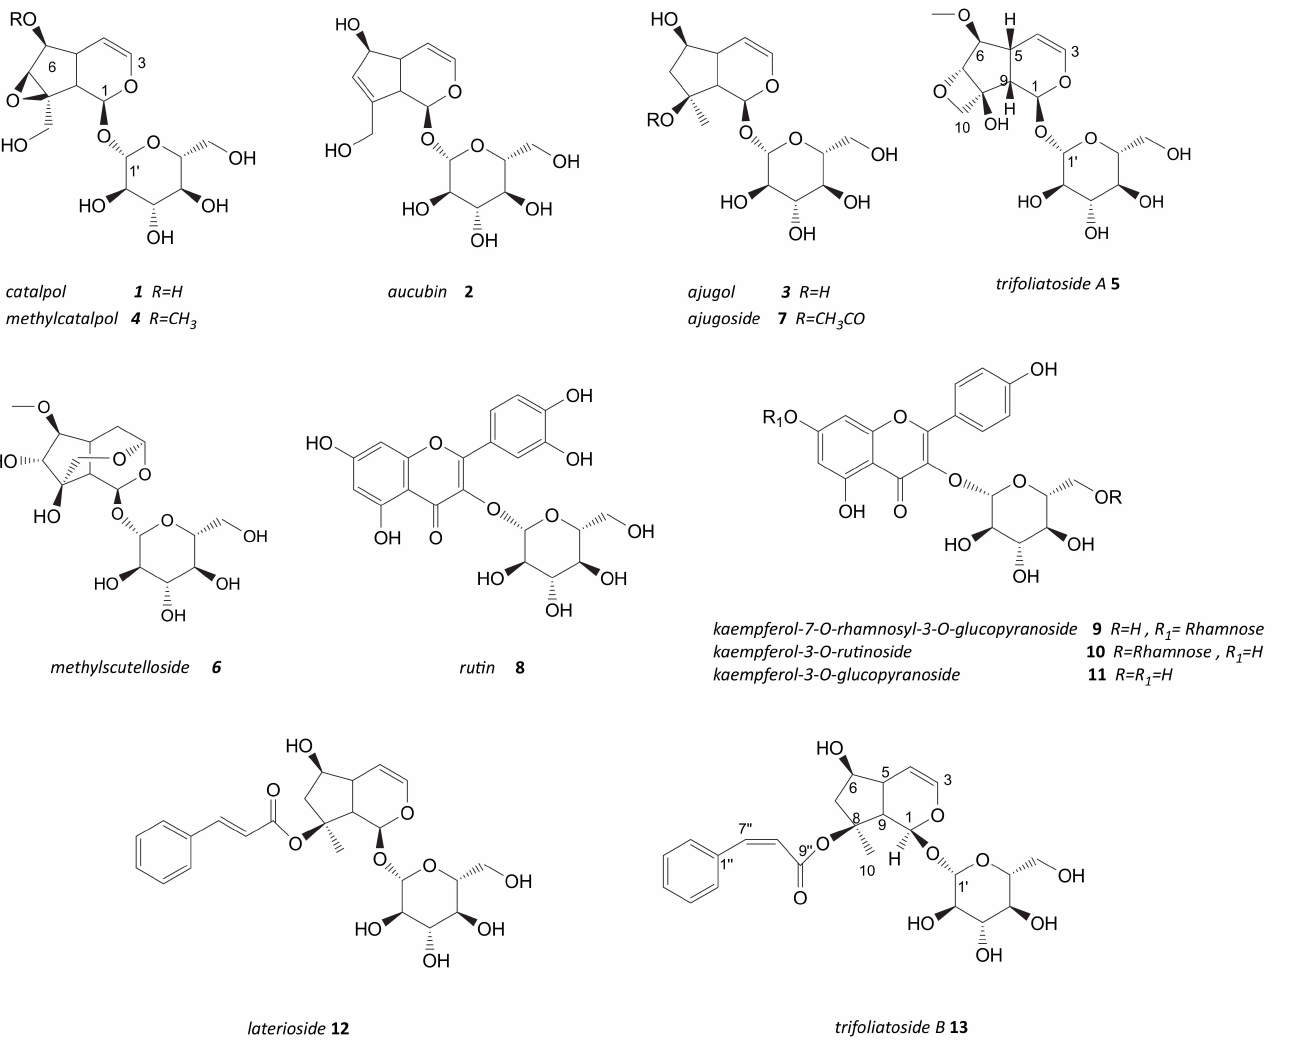
Figure 5. Chemical structure of iridoids ( 1 – 7 , 12 – 13 ) and flavonols glycosides ( 8 – 11 ) isolated from leaves of S.